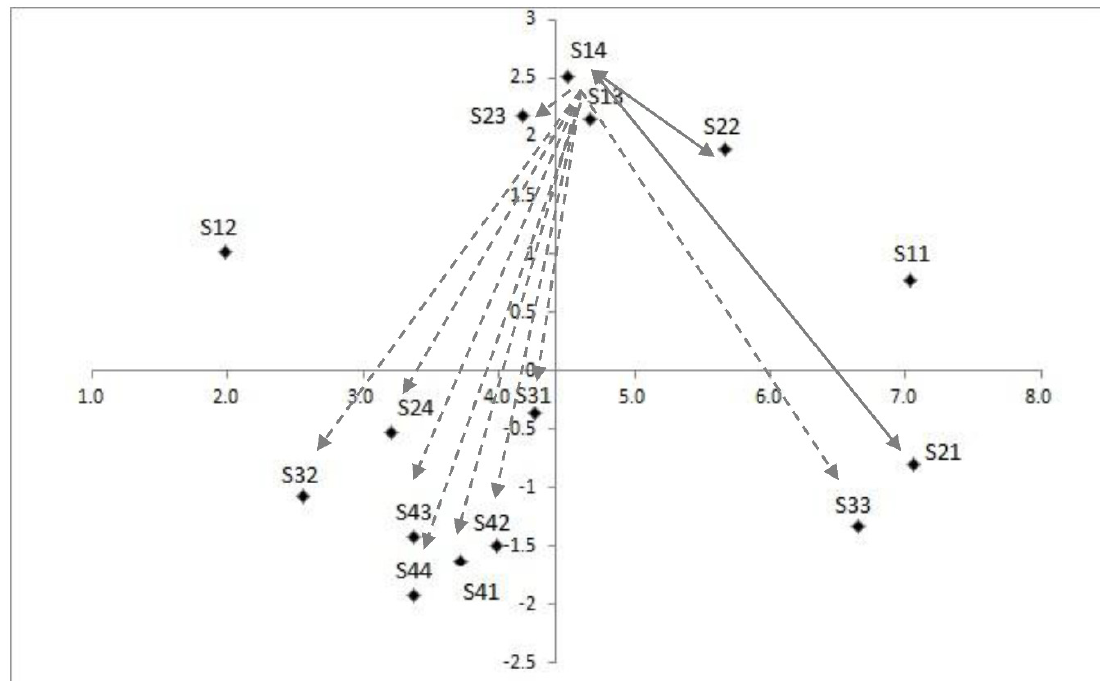
Figure A3. Casual Diagram between S13 and Other Criteria.